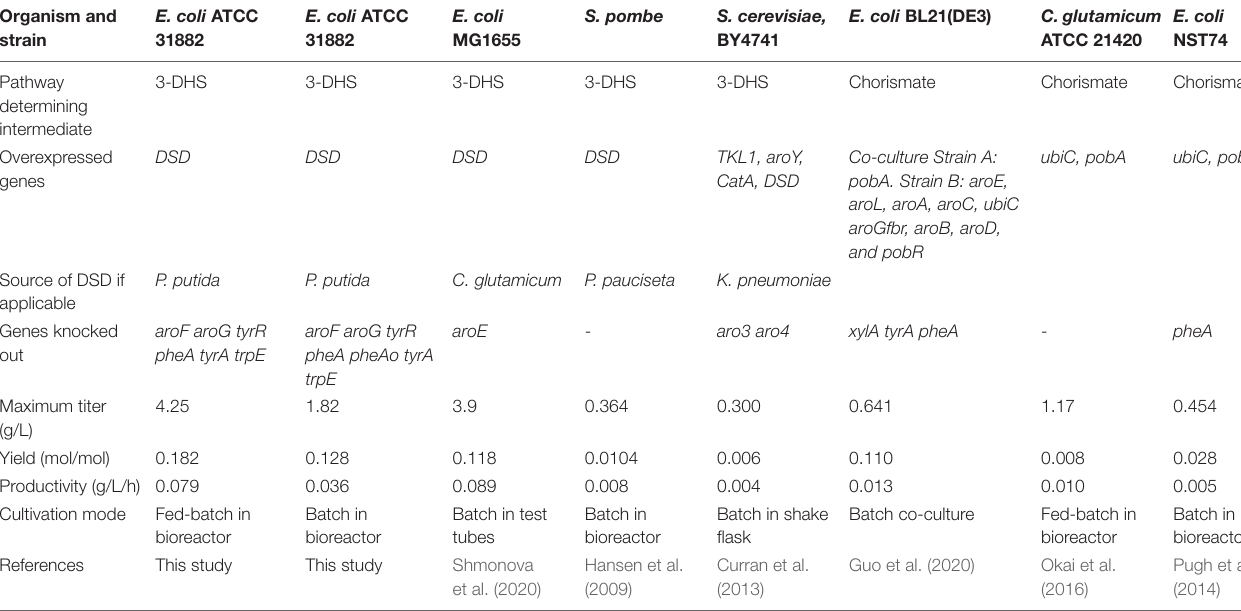
TABLE 1 | Comparison of results on microbial PCA production obtained in this study with those from the literature. Organism and